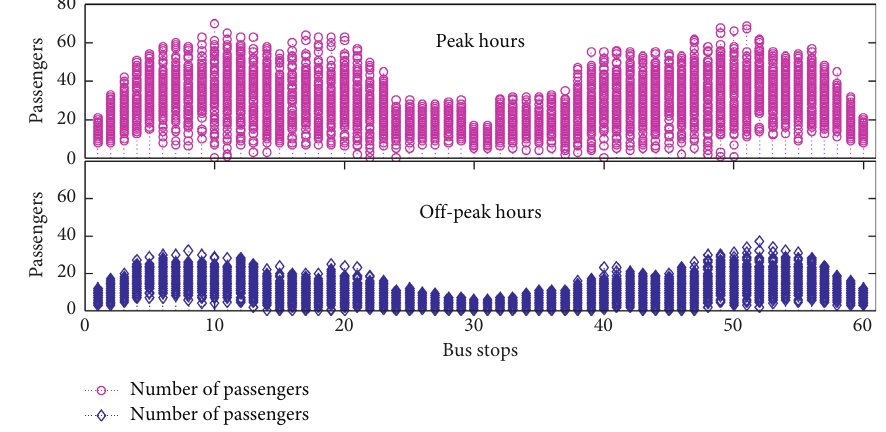
Figure 11: The measured passenger data of the bus route.